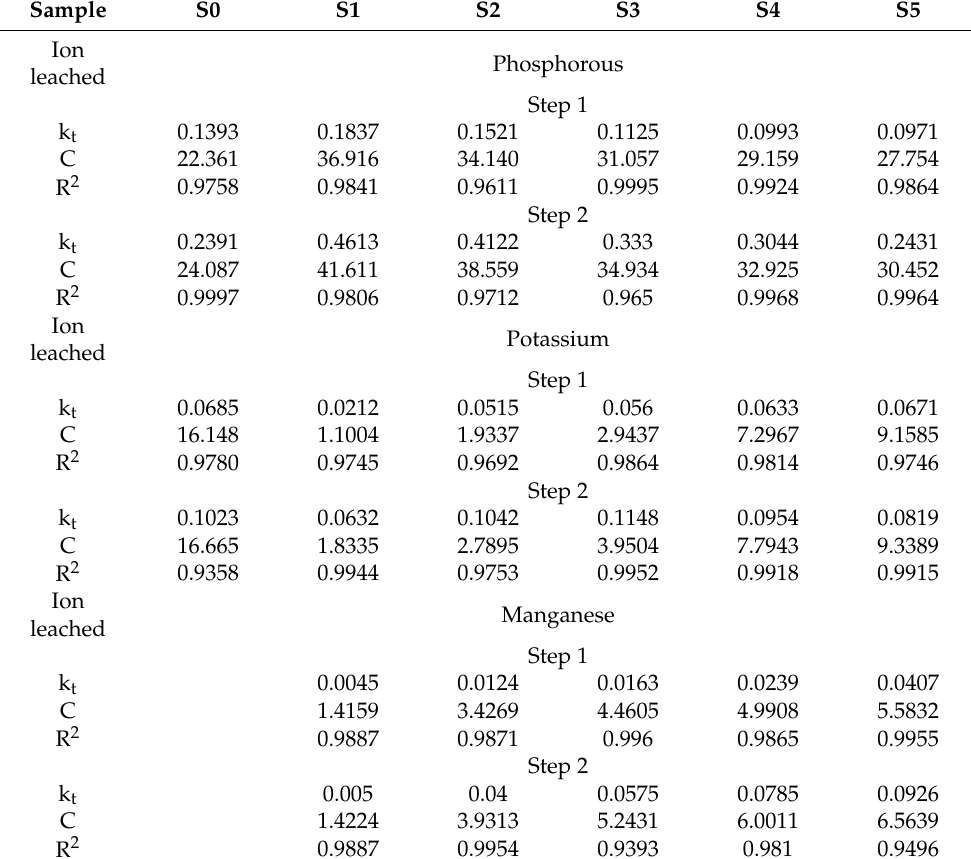
Table 4. Intraparticle diffusion parameters for both steps for phosphorous, potassium and manganese ions leaching